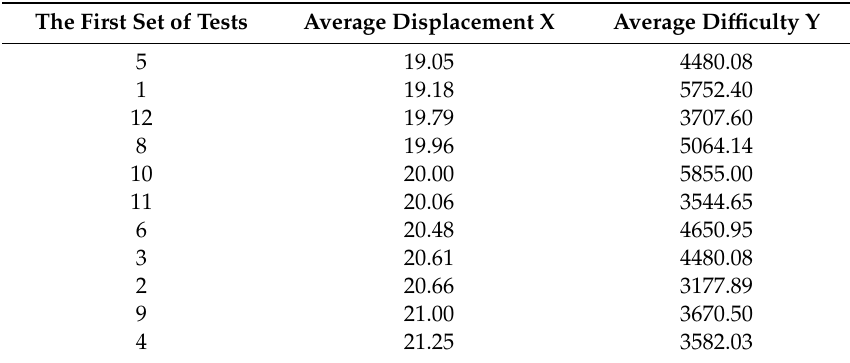
Table 5. Data sorting according to average